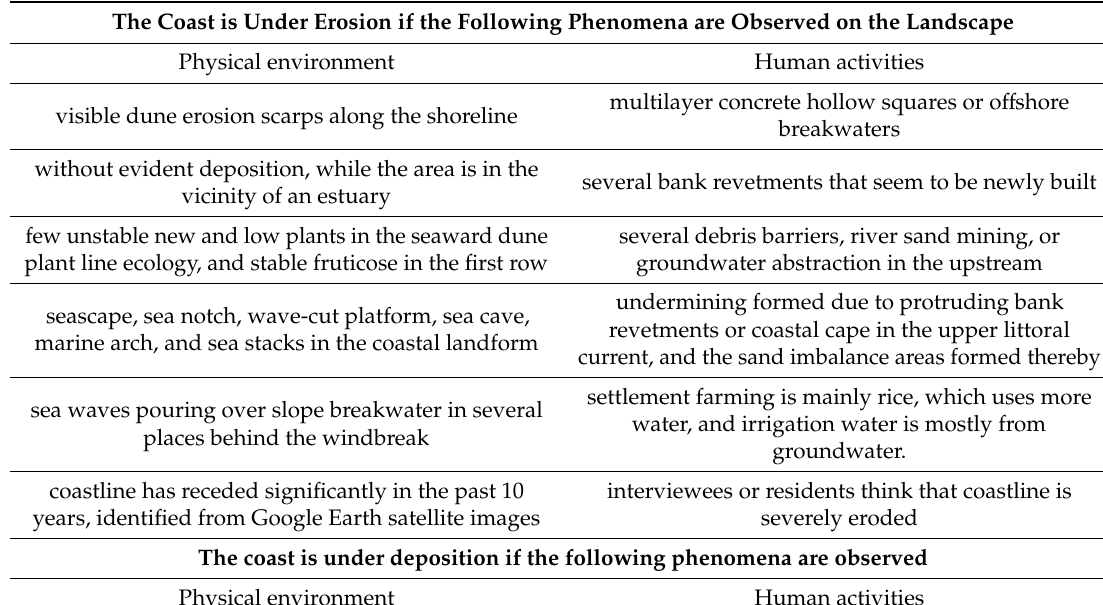
Table 1. Drone aerial photographs of signs corresponding to ground survey